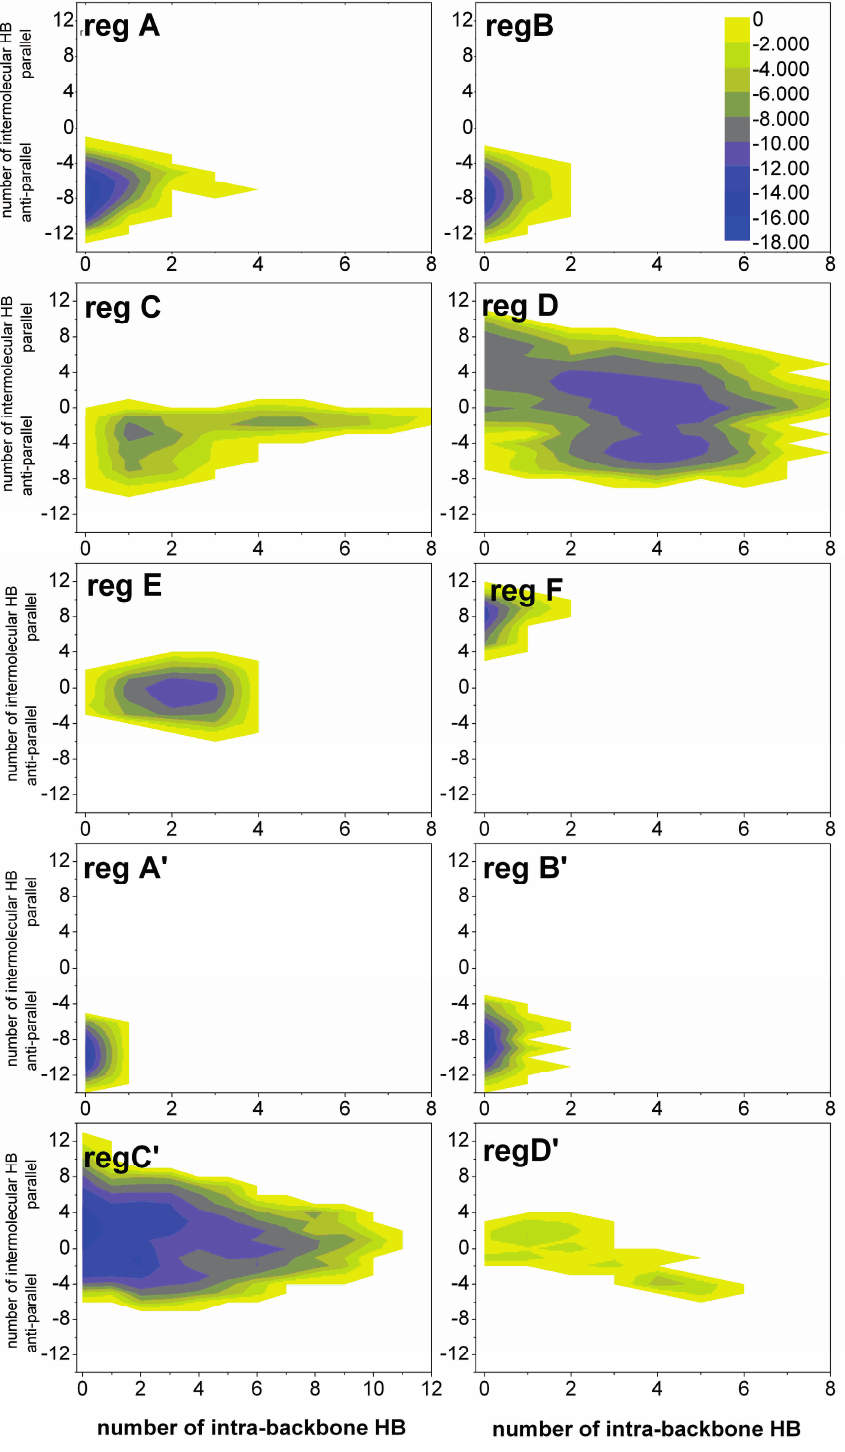
Figure 3. The free energy surfaces (in kJ/mol) for A–F regions of the ( α -syn12) 2 dimer at the physiological pH and A'–D' regions at the acidic pH projected on the number of intra-backbone hydrogen bonds and the number of inter-backbone hydrogen